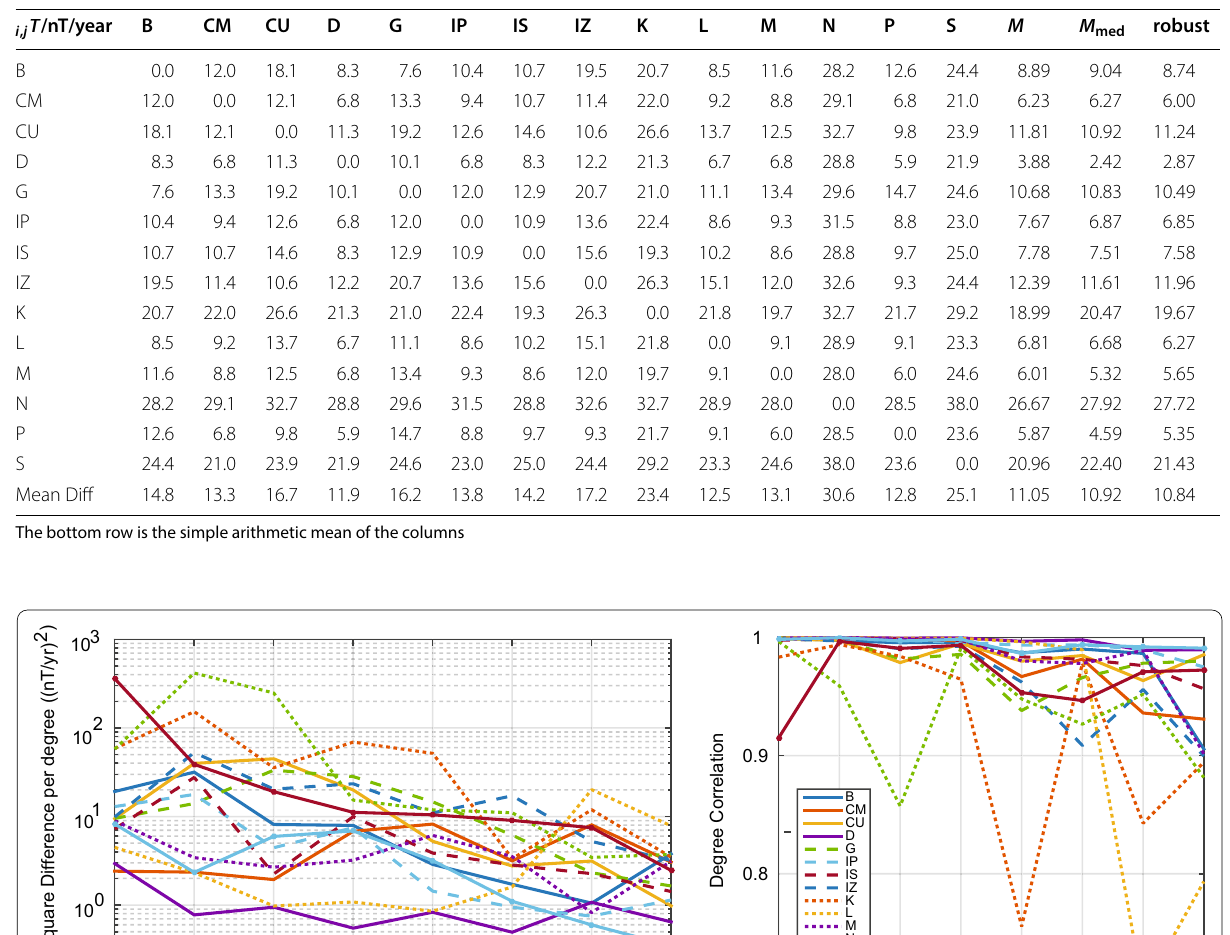
Table 5 Root-mean-square vector field differences i , j T in units nT/year between SV candidate models and also between candidates and the arithmetic mean reference models M , median reference model M med and robust Huber-weighted model in the rightmost columns